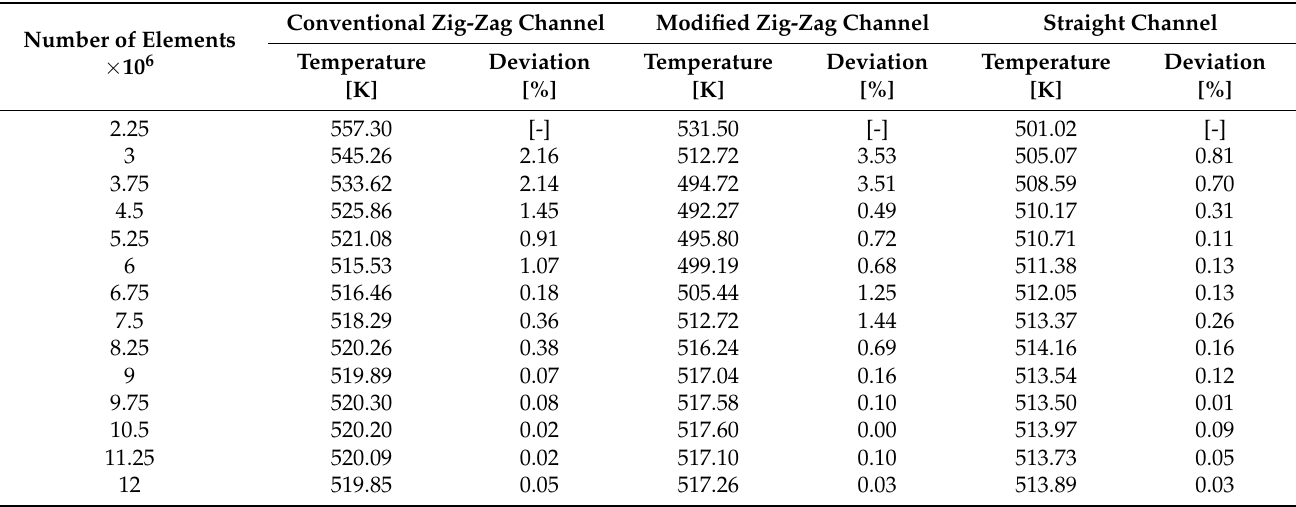
Table 3. Mesh independence analysis for channel configurations of the PCHE (temperature at the cold channel